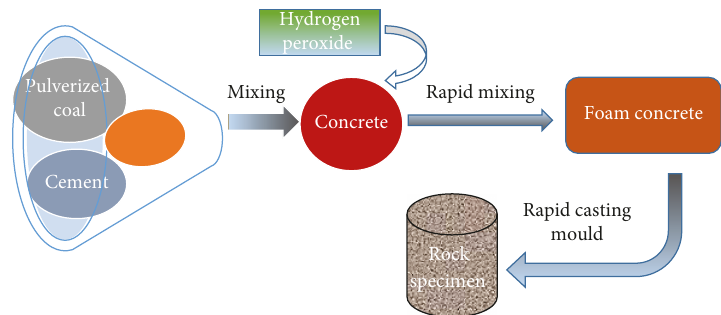
Figure 2: Preparation process for a gas-a ff ected heterogeneous soft coal mass